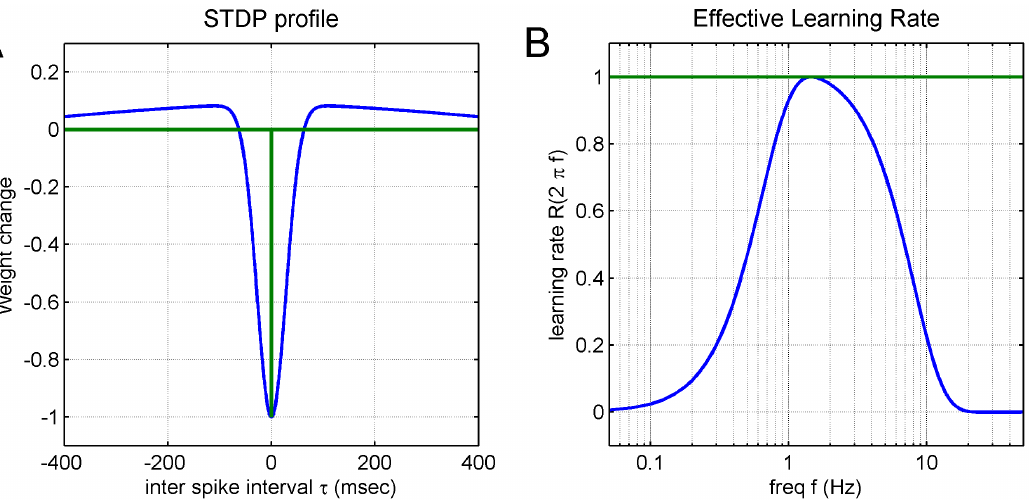
Figure 2. Relation between iSTDP profiles and VOR learning characteristics. Panel A shows two iSTDP profiles, where vestibular synaptic weight change ( K t ð Þ of equation (2) in Methods) is plotted against interval t between spikes in the two separate vestibular and cerebellar input streams. Panel B shows the corresponding learning rate functions R v ð Þ , v ~ 2 p f (given by equation (7) in the Methods) plotted against frequency f of head motion. The green curve in panel A represents an idealized iSTDP profile with an infinitely narrow and deep LTD dip surrounded by an infinitely wide and shallow LTP plateau. This corresponds to an ‘all-pass’ filter where learning is equally efficient at all frequencies greater than zero, as shown by the corresponding green line in panel B. The blue curve in panels A and B is a filter chosen so that learning is concentrated in the region 0.3–10 Hz as suggested by data for VOR adaptation (see Methods). Its learning rate falls to 20% of maximum at 0.3 and 10 Hz (panel B). The corresponding iSTDP profile (panel A) has a half-width at 20% maximum of 49 ms. The general shape of the iSTDP profile derives in part from the requirement that synaptic weights be stable for tonic or very slowly varying, asynchronous, inputs, which implies that the total area under the profile must be zero (so that the total areas representing synaptic potentiation through LTP, and depression through LTD, must